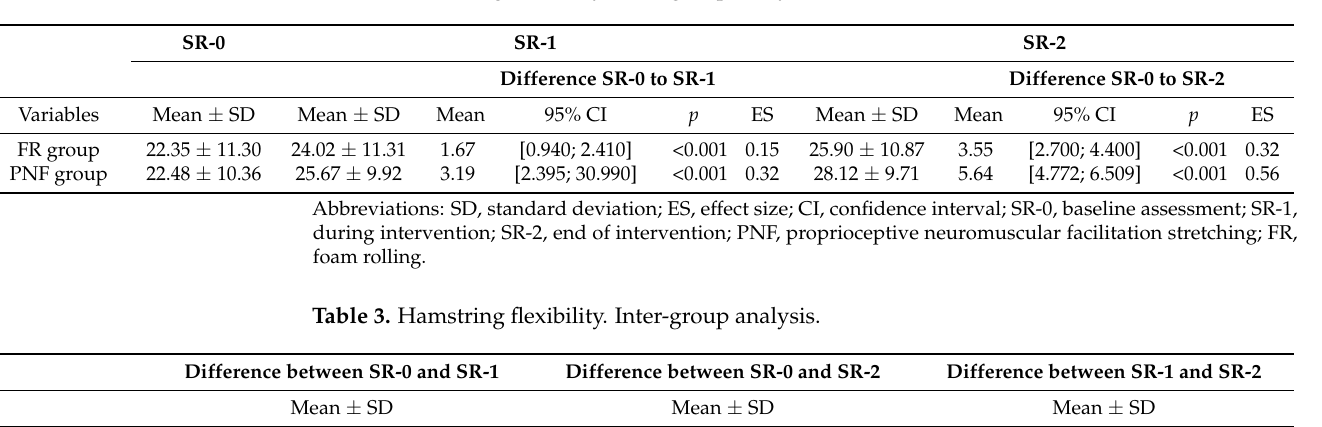
Table 2. Hamstring flexibility. Intra-group analysis.